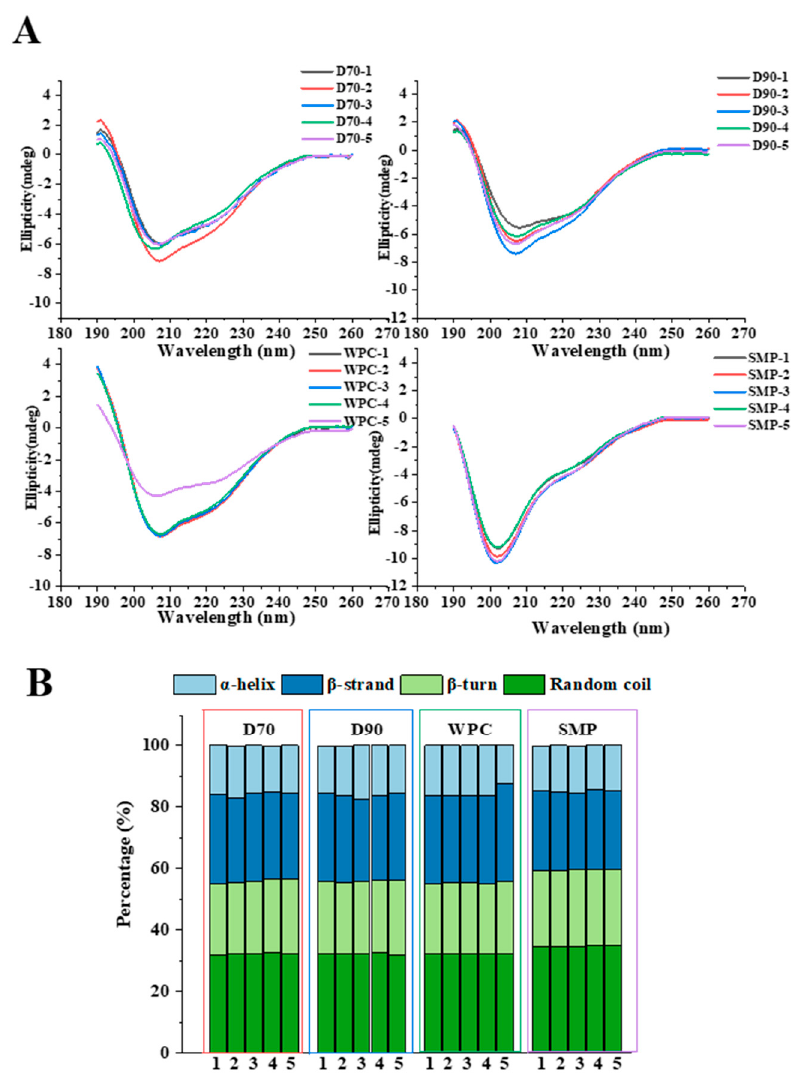
Figure 4. Circular dichroism spectroscopy of D70, D90, WPC, and SMP samples. Circular dichroism spectroscopy ( A ); secondary structure content ( B ).